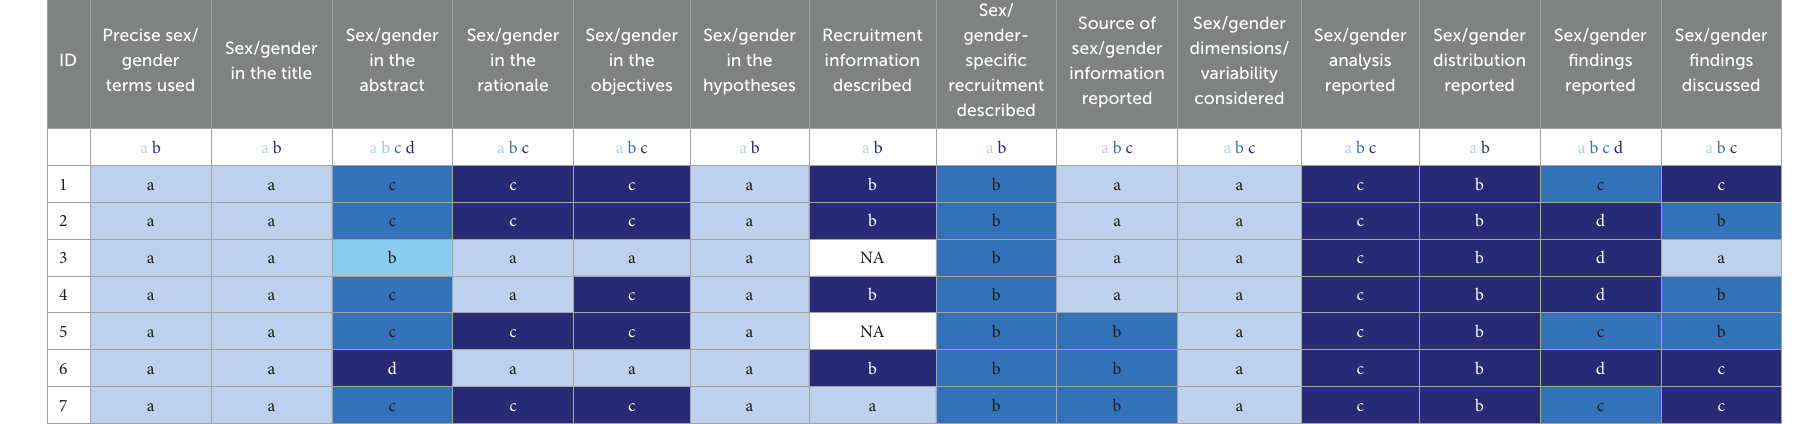
TABLE 2 Assessment matrix for the consideration of sex/gender in publications assessing sex/gender in the association between residential green space and self-rated health.